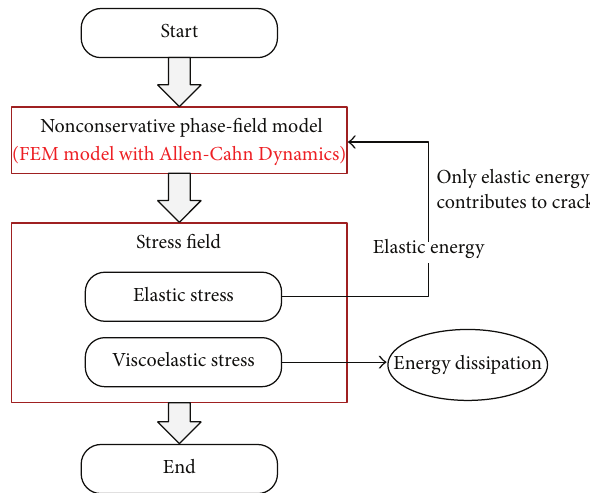
Figure 4: Quasi-brittle cracking calculation flowchart.